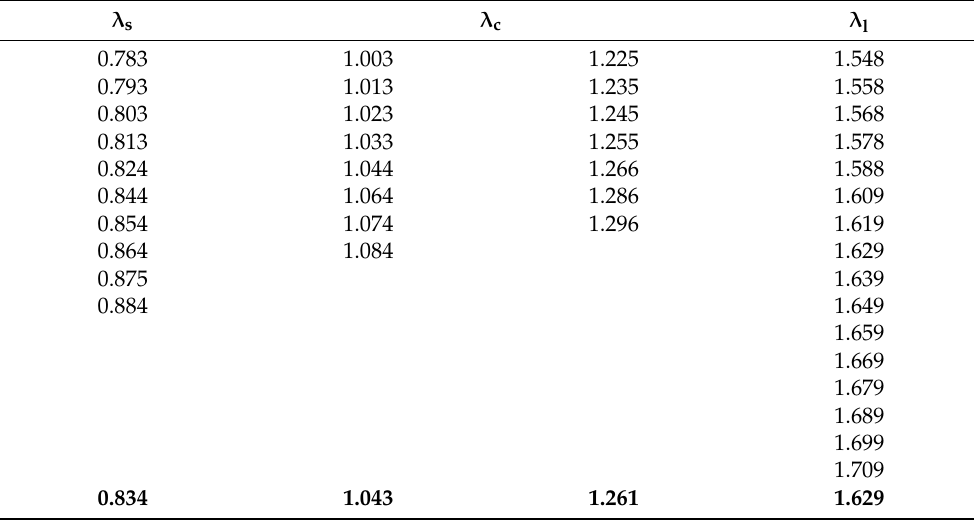
Table A2. Wavelengths used for computing the feldspar band-depth index with EO-1 Hyperion. The last row shows the mean.